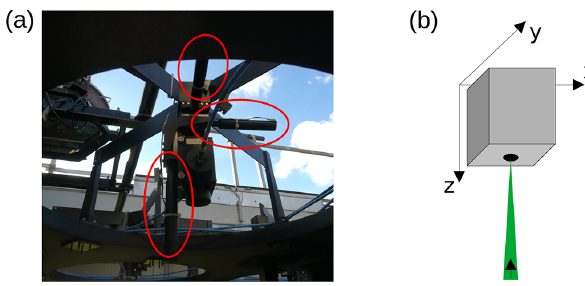
Figure 4. (a) Receiving optical system with the three axis servomo- tors (red circled components). (b) Schematic of the receiving block